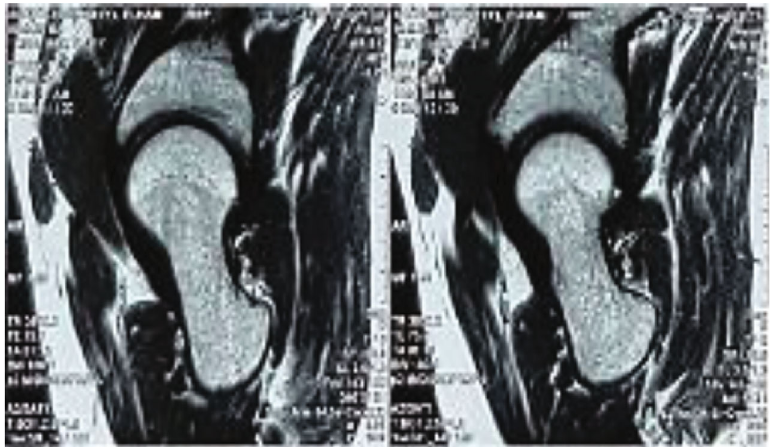
Figure 3: T2-weighted MRI of the hip showing normal condition of the hip cleared from any abnormal lesion